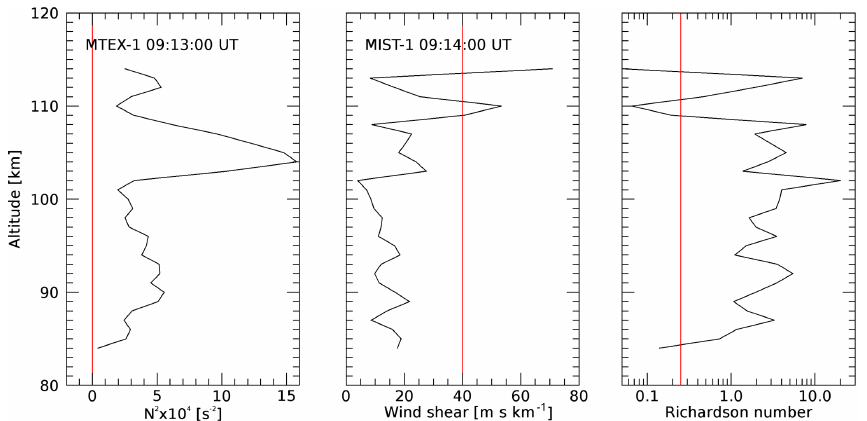
Figure 15. Buoyancy frequency from CONE upleg temperatures, horizontal wind shears from TMA winds, and Richardson numbers for the first salvo. The red line in the right panel indicates Ri = 0 . 25.